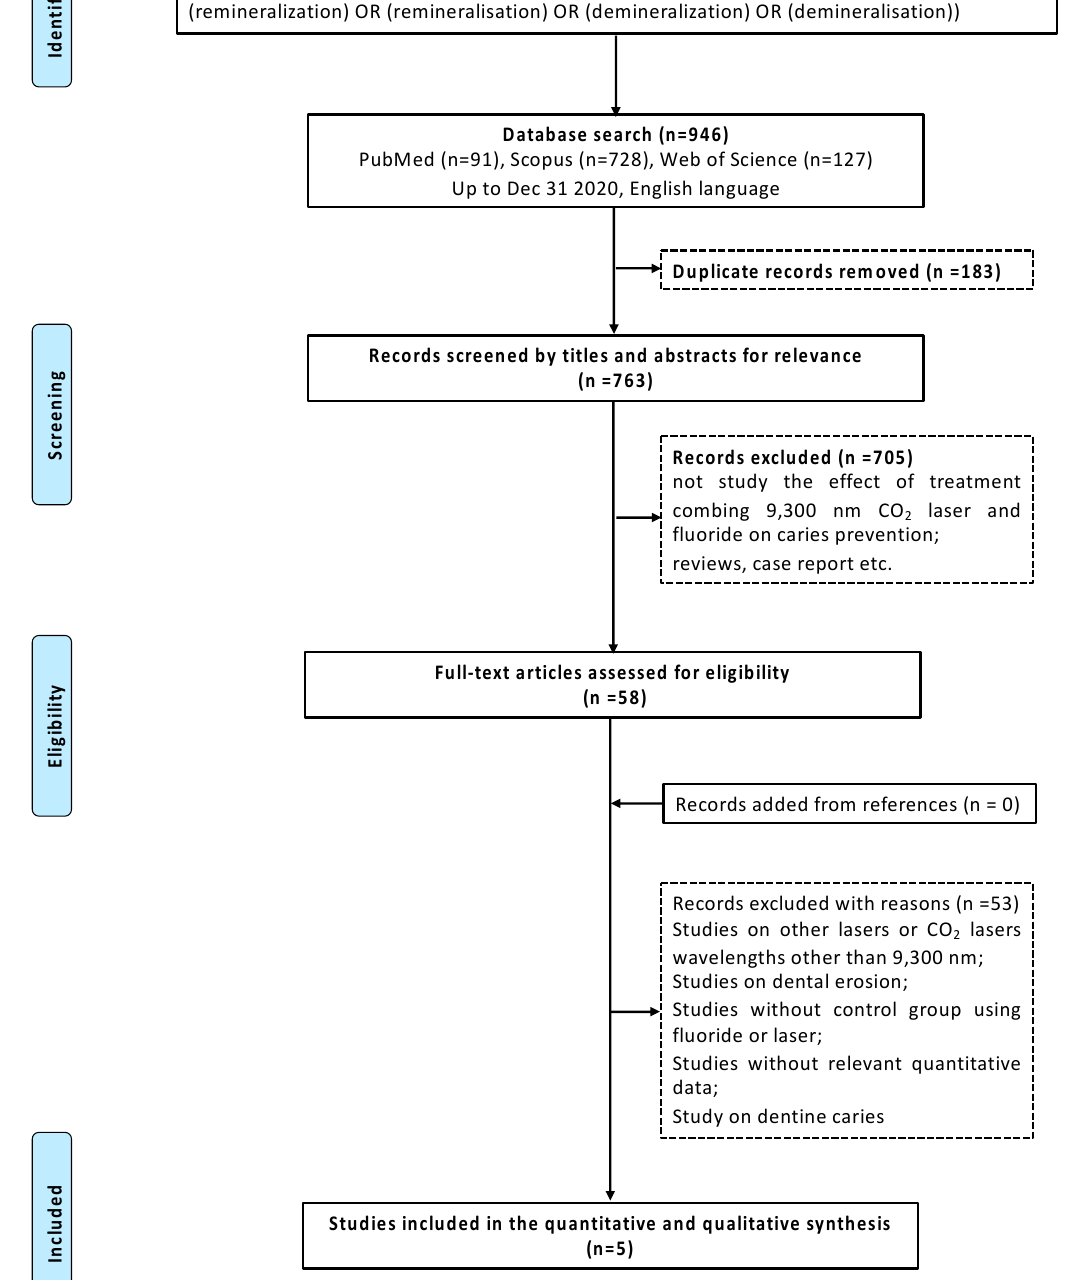
Figure 1. A flowchart diagram of the study selection process, according to the PRISMA statement.